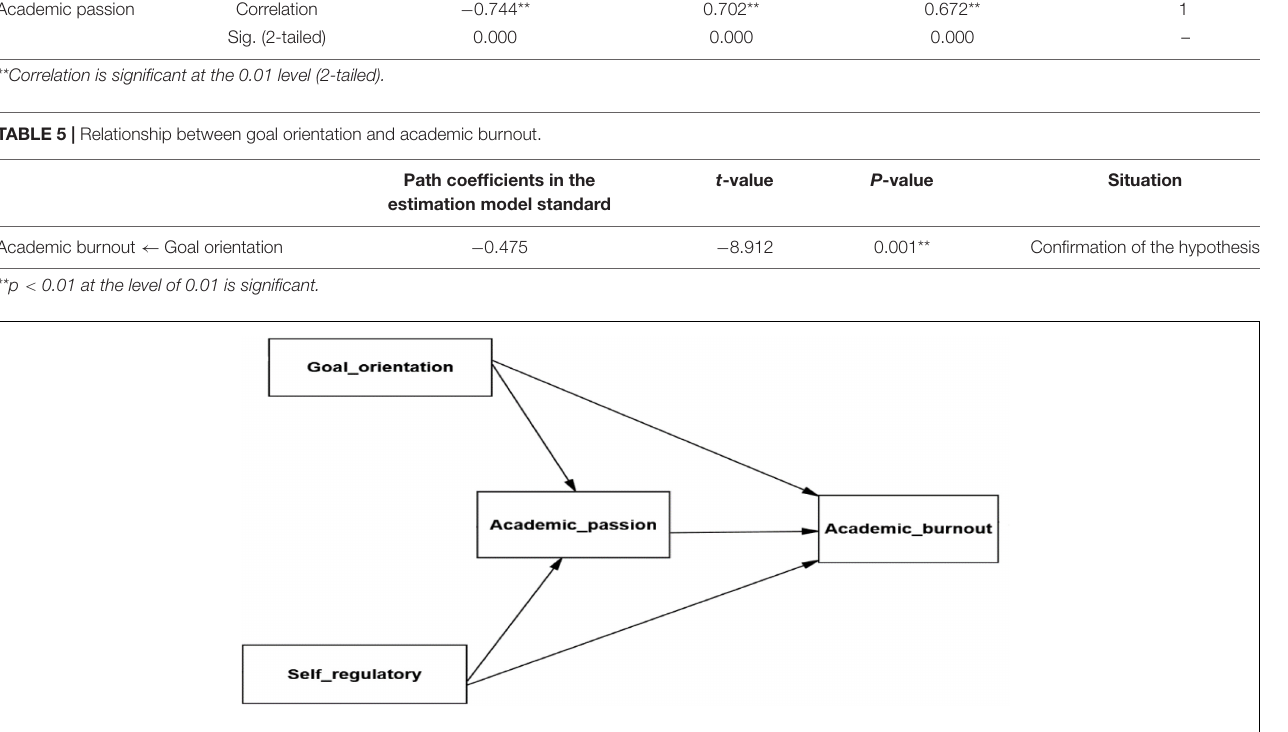
FIGURE 1 | Research